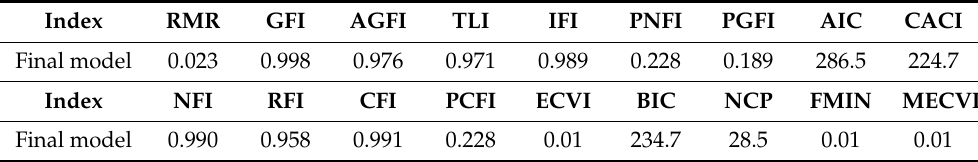
Table 7. Goodness-of-fit indexes of effectiveness final model in